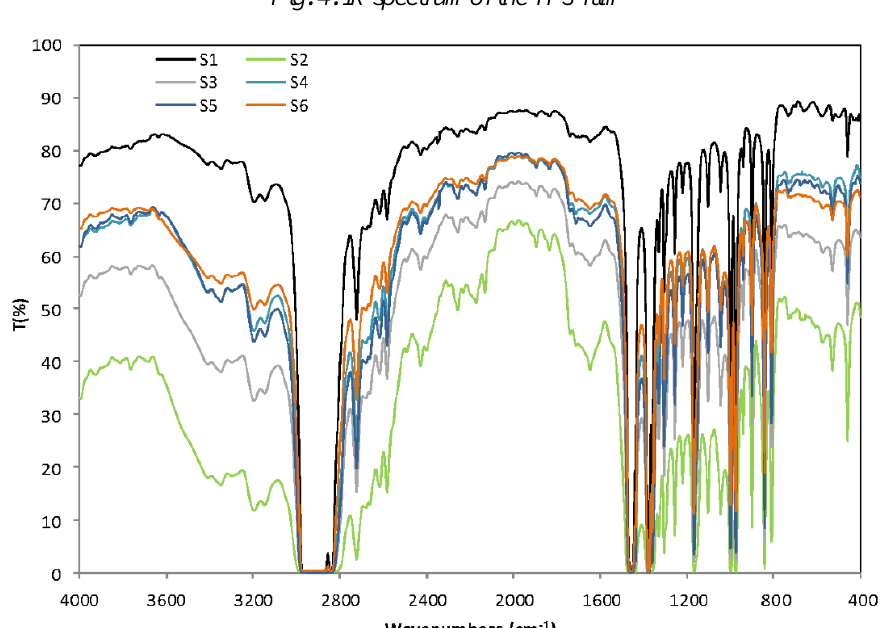
Fig. 5. FTIR spectra of 6 formulations of PP, and PP/TPS